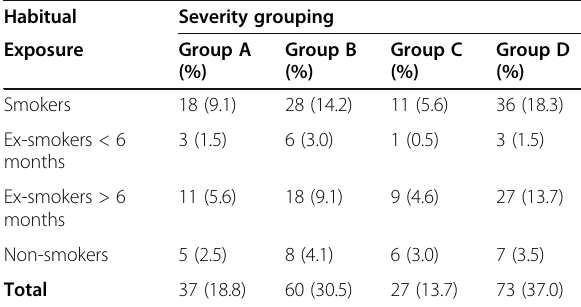
Table 11 Distribution of habitual exposure with severity